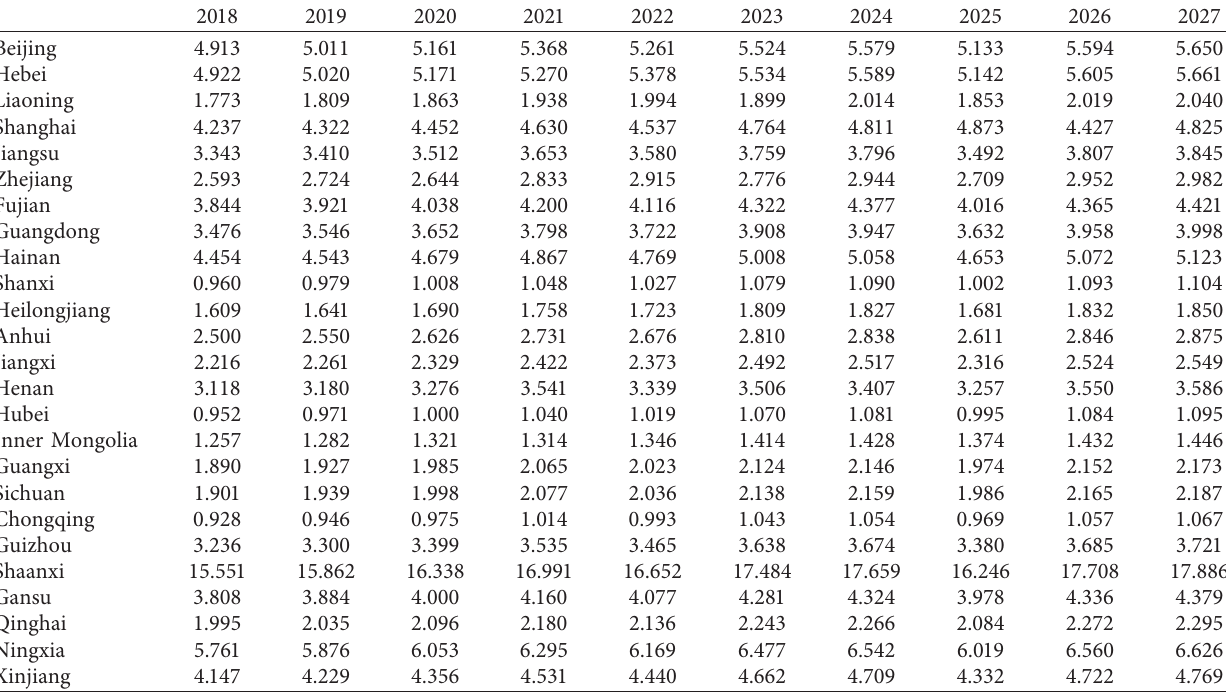
Table 8: Forecast of labor income share in 25 provinces by fractional Hausdorff grey model (unit: 10 –8